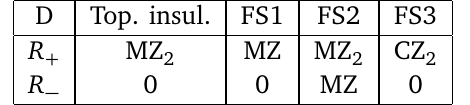
Table 1: Summary of the topological classifications of both particle-hole symmetric KM and BHZ Hamiltonians taking into account commuting ( R + ) and anticommuting ( R − ) reflection symmetries. The first column refers to the case where the system is gapped, while the rest of the columns refers to a gapless Hamiltonian. FS1, FS2 and FS3 reffer to the position of the accidental crossings, or Fermi surfaces in the reciprocal lattice: For FS1, the accidental crossing is placed on the mirror plane and at a high-symmetry point. For FS2, the accidental crossing is on the mirror plane, but away from a high-symmetry point, and for FS3, the accidental crossing is away from both, high-symmetry points and the mirror plane. D Top. insul. FS1 FS2 FS3 R + MZ MZ MZ CZ 2 2 2 R − 0 0 MZ